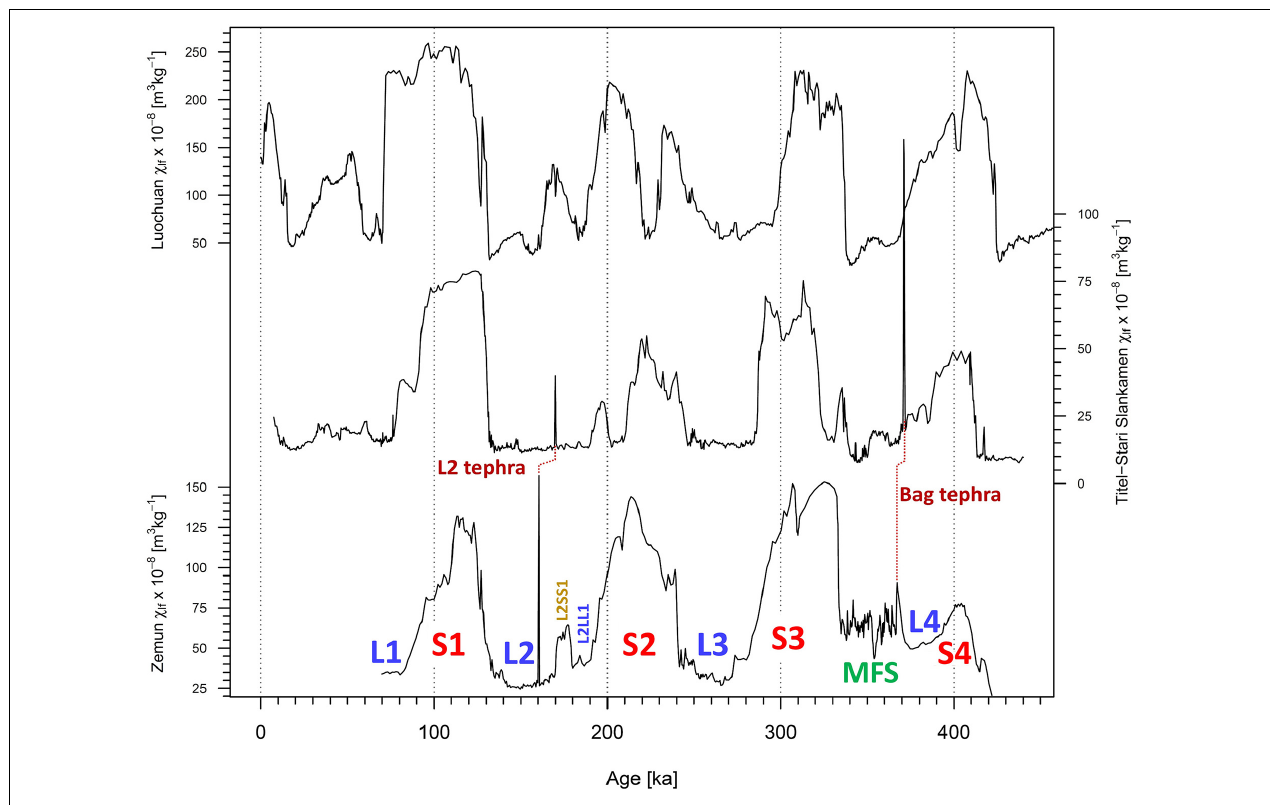
FIGURE 11 | Comparison of the χ lf record from the LPS at Zemun, Titel-Stari Slankamen, and Luochuan on their individual age scales. Note the very similar chronostratigraphic depiction of the potential tephra layers at Zemun and Titel-Stari Slankamen. Differences in onsets and demises of different paleosol units may result from different age models and applied indirect (correlative) dating. Details are discussed in the